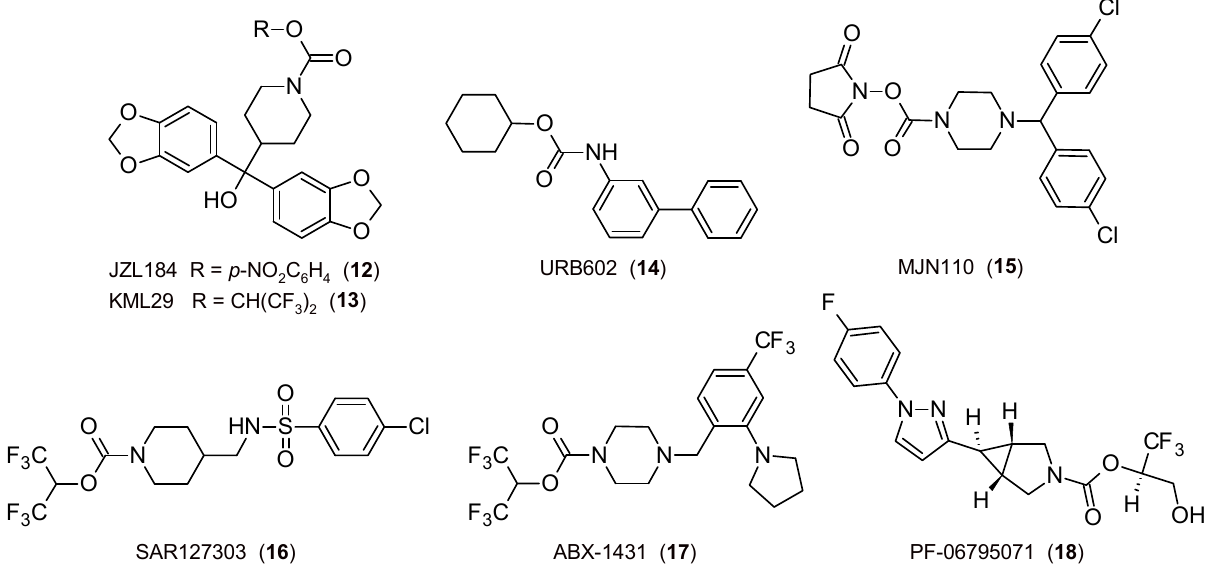
Figure 4. The 2D structures of selected FAAH